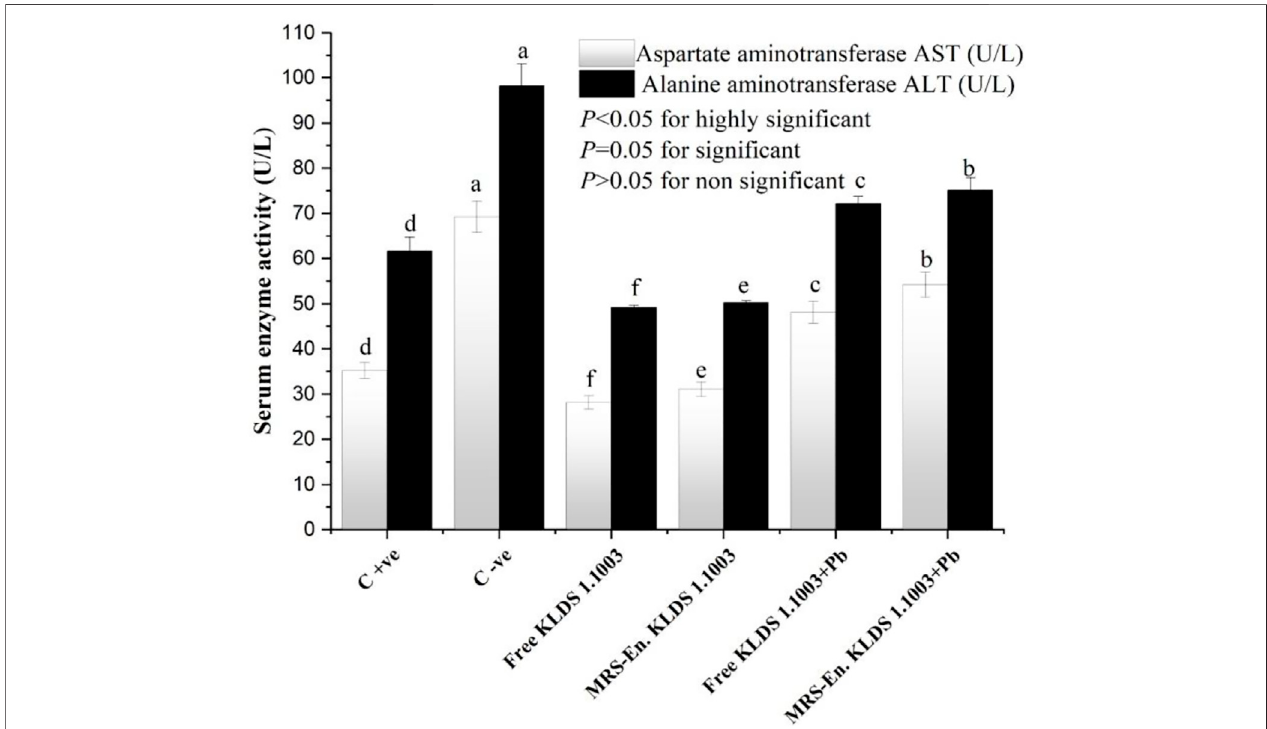
FIGURE 7 | Effects of free and MRS-based microencapsulated L. acidophilus KLDS 1.1003 on oxidative stress induced by chronic Pb exposure on the activity of marker enzymes such as aspartate aminotransferase (AST) and alanine aminotransferase (ALT) in the serum of mice. Values are mean ± SD.